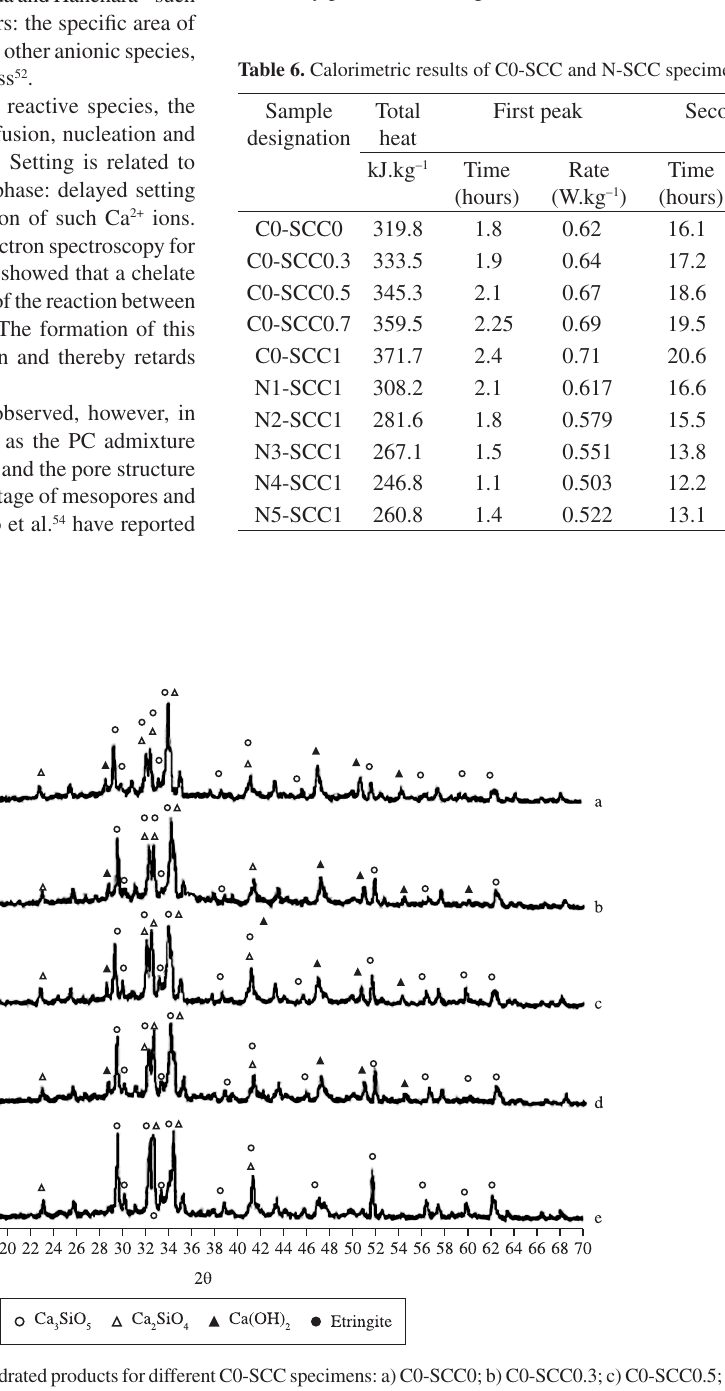
Figure 5. XRD results indicating the formation of hydrated products for different C0-SCC specimens: a) C0-SCC0; b) C0-SCC0.3; c) C0-SCC0.5; d) C0-SCC0.7; and e)